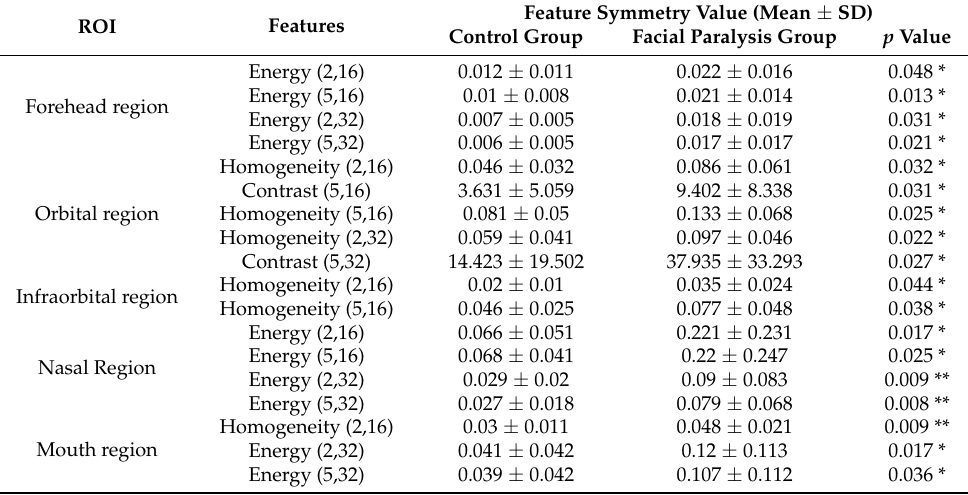
Table 7. Symmetry measurements of texture features using the Euclidean distance (the offset distance ∆ of the GLCM is set to 2 and 5, and the maximum gray level is set to 16 and 32). Feature Symmetry Value (Mean ± SD) ROI Features Control Group Facial Paralysis Group Energy (2,16) Forehead region